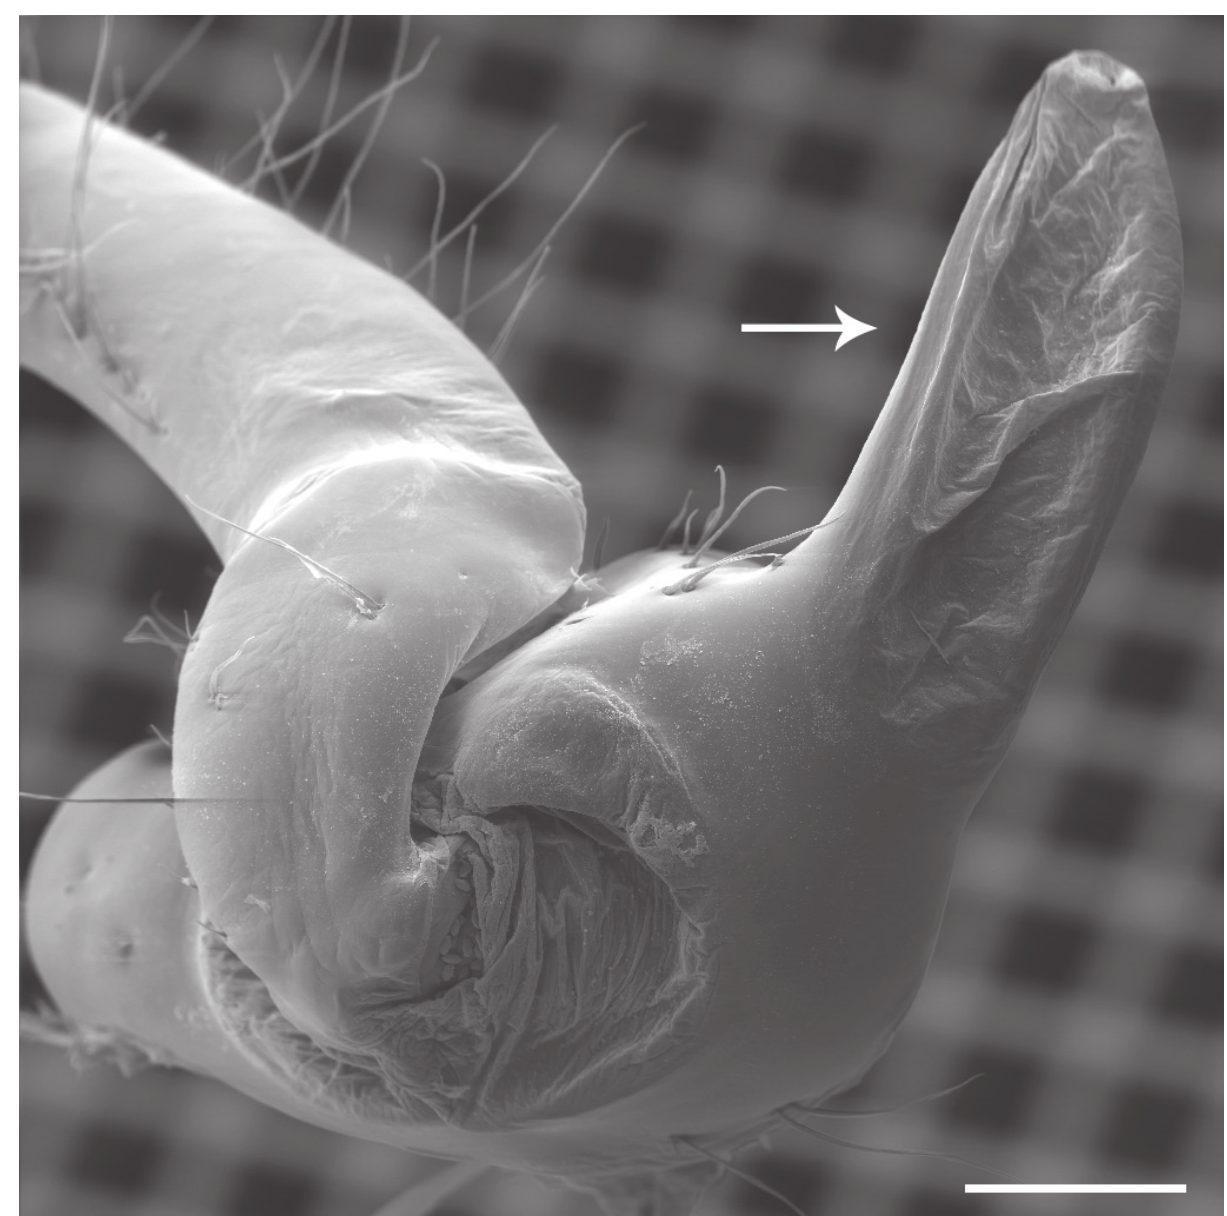
Figure 8. Aegla charon n. sp., male paratype (CL 20.57 mm; CLR 23.95 mm) (MZUSP 35194), sexual tube (arrow) on the coxa of the left fifth pereopods. Scale bar = 500